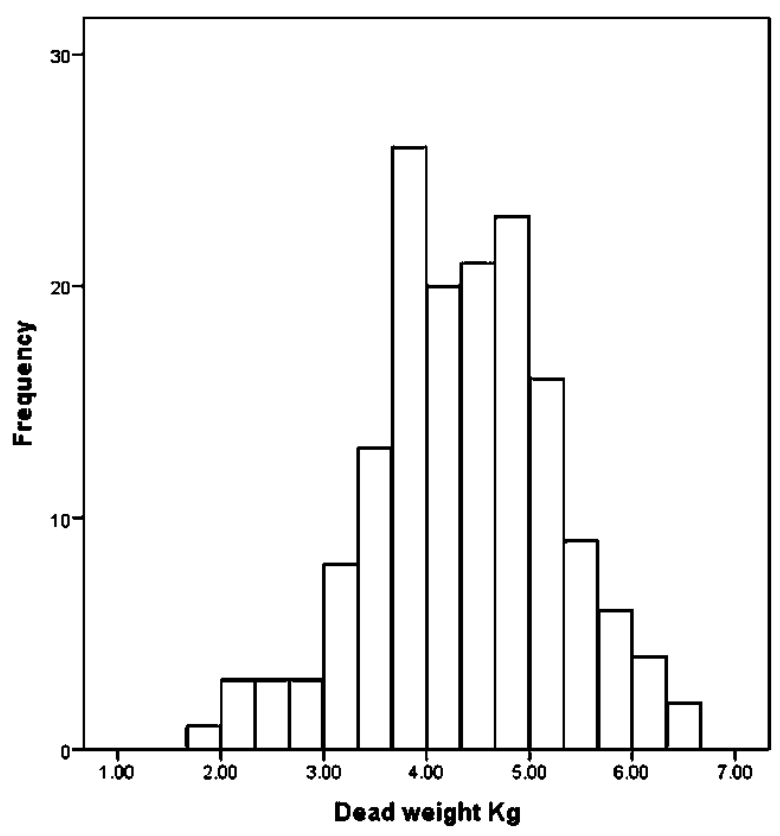
Figure 8. The distribution of kid dead weights ( n = 158).